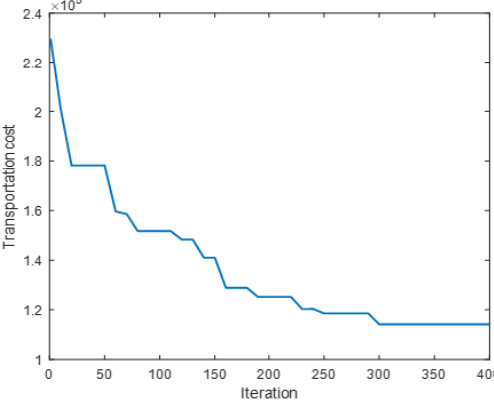
Figure 12. AGA algorithm cost target iteration curve.